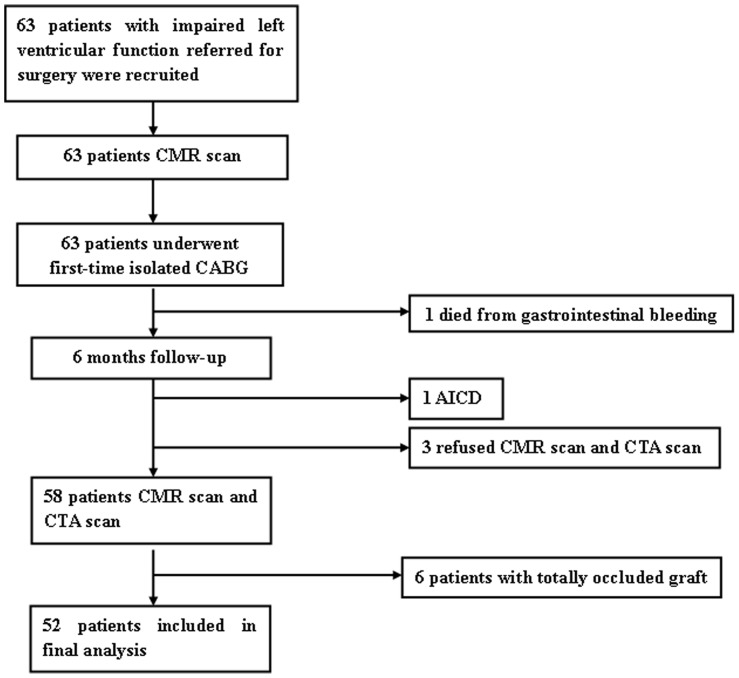
Flow Diagram of Patients Recruitment.AICD, automated implantable cardiac defibrillator; CABG, coronary artery bypass grafting; CMR, cardiovascular magnetic resonance imaging; CTA, computed tomography angiography.